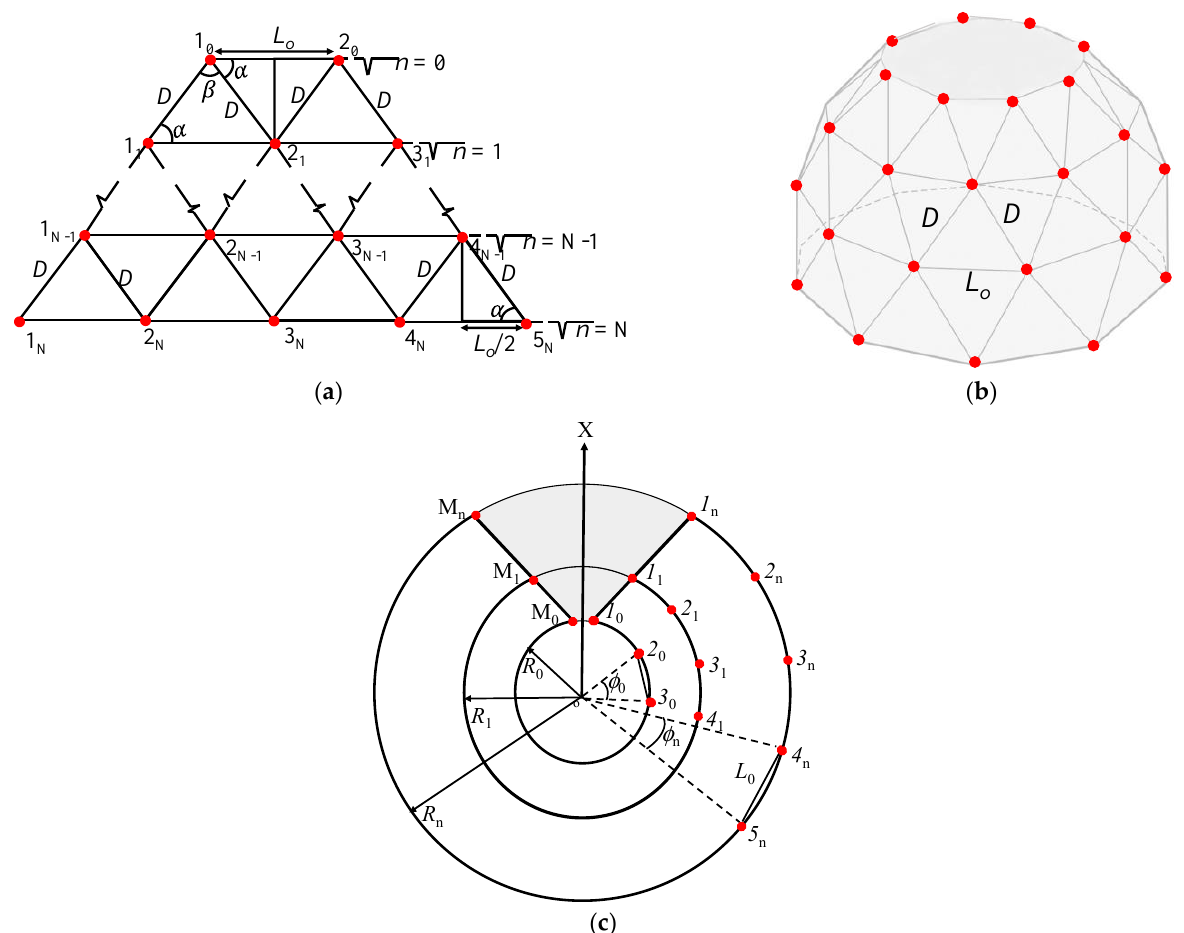
Figure 2. Geometry of the geodesic triangle.